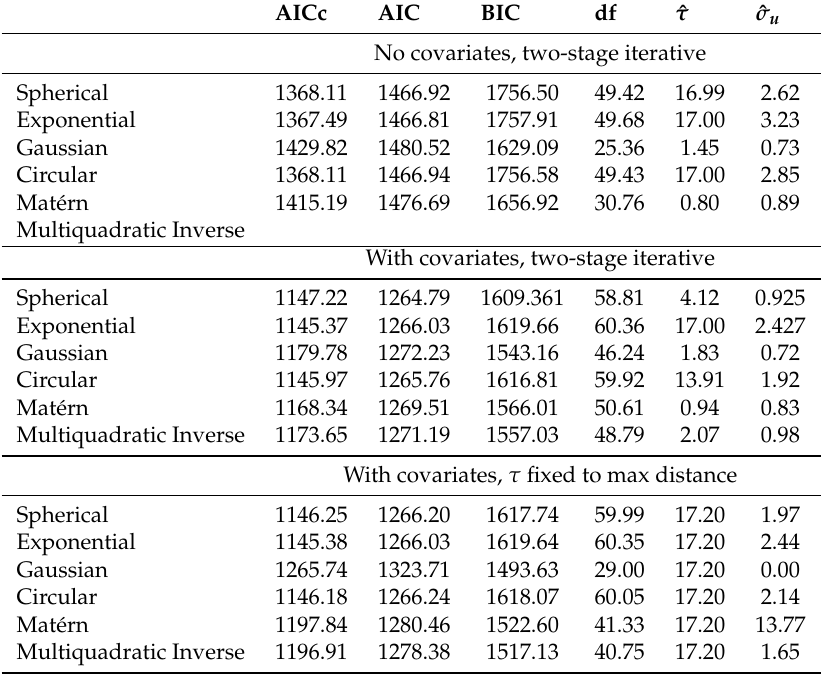
Table 3. Akaike information criterion (AIC), corrected AIC (AICc), and Bayesian information criterion (BIC) values for the three model-building scenarios and for different covariance functions, together with the parameter estimates for τ and σ u